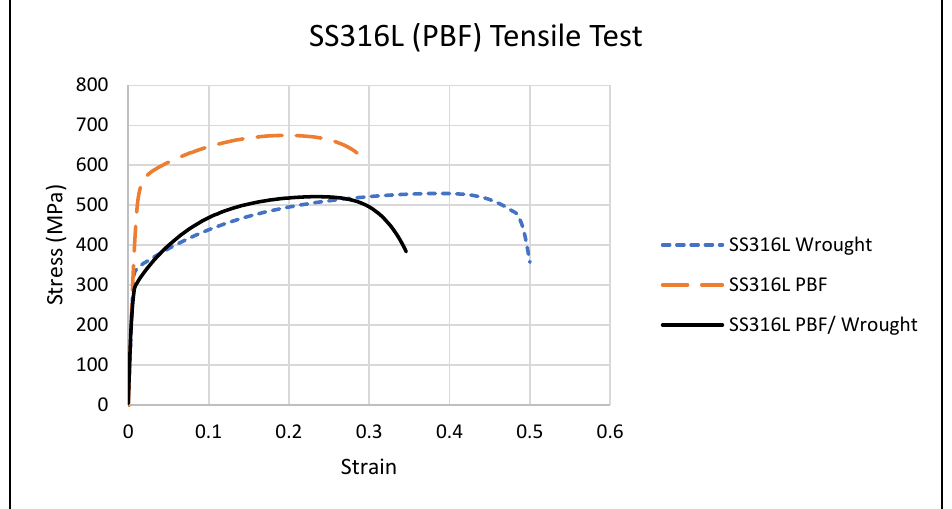
Figure 4. Average tensile test stress/strain.